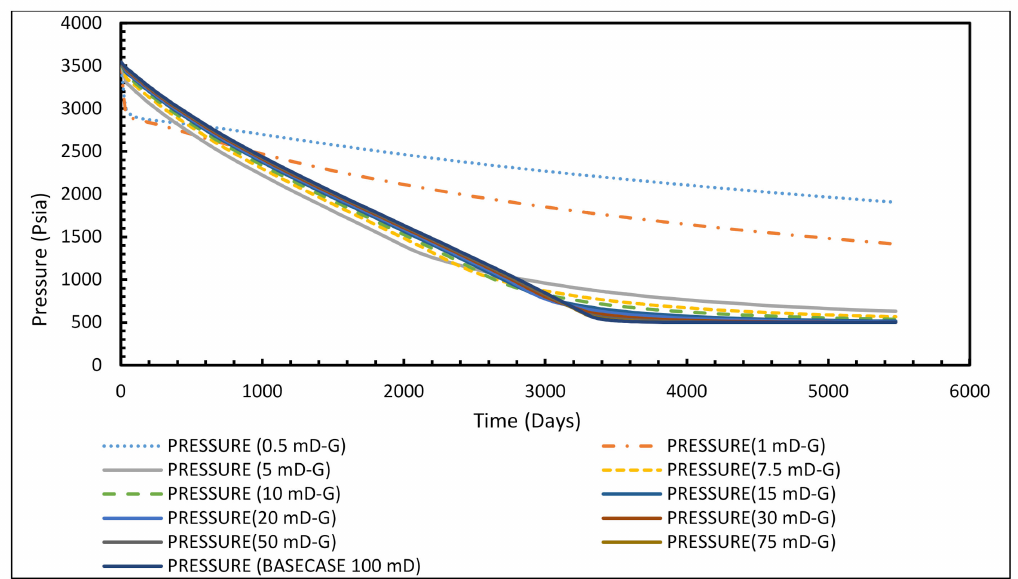
Figure 2. Reservoir pressure versus time at the wellbore for global grid analysis.